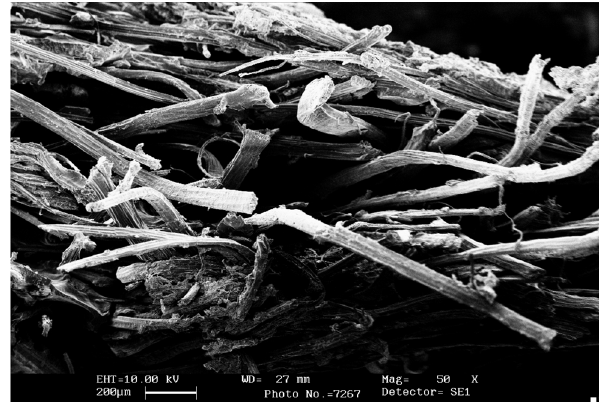
Figure 18: SEM for (15% jute fiber by weight) composite material with coating at